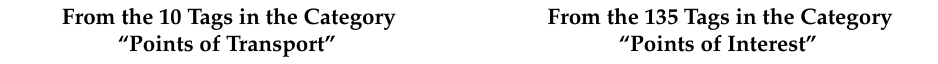
From the 135 Tags in the Category “Points of Interest” bakery bank bar beverages bicycle_rental bicycle_shop biergarten bookshop butcher caf é car_sharing cinema community_center convenience doctors fast_food greengrocer kindergarten kiosk laundry library